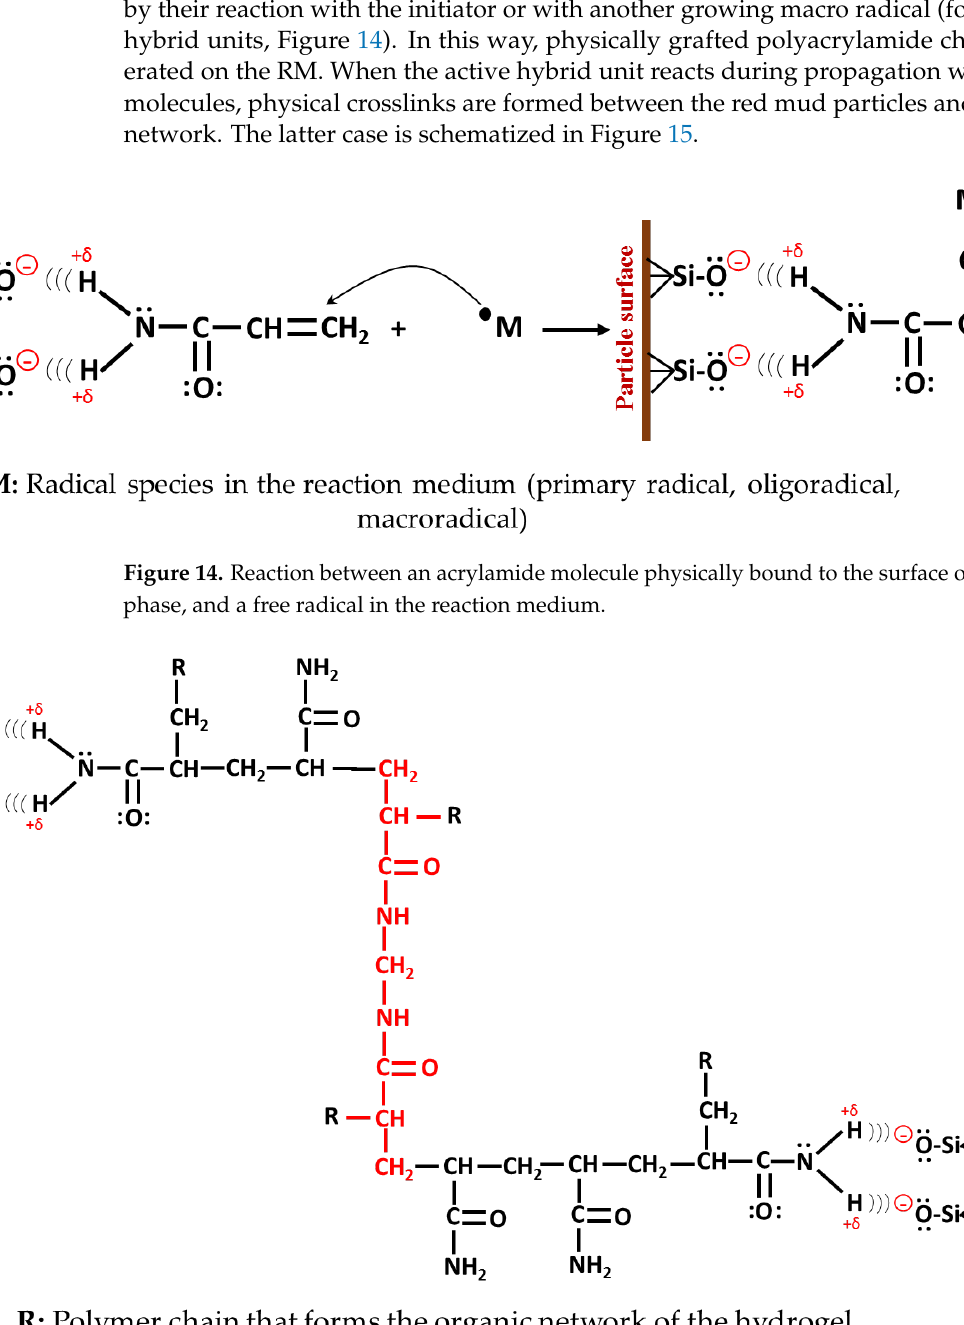
Figure 15. Physical crosslinking between red mud particles and the organic network of PAAm.